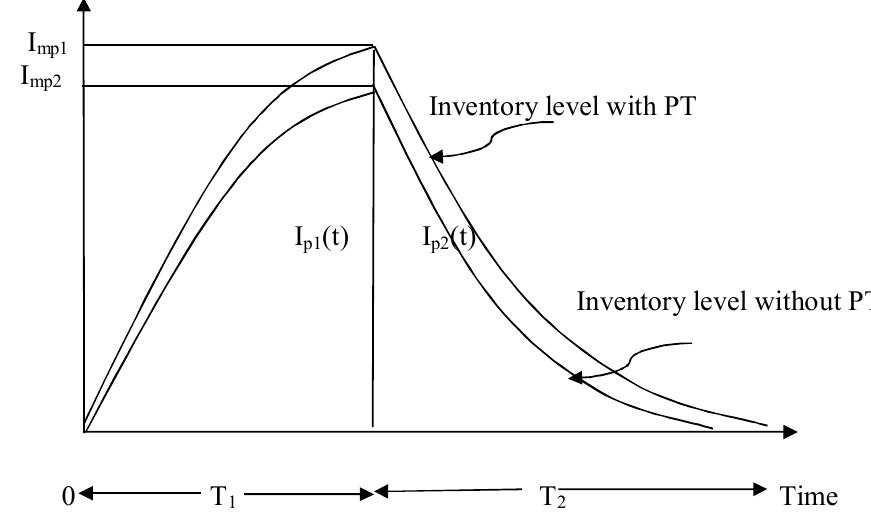
Fig. 1. The graphic representation of inventory model for